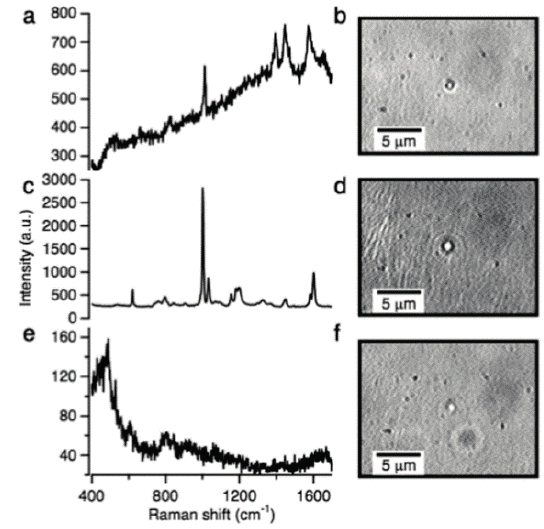
Figure 14. Raman spectra and microscope images of trapped particles of either ( a , b ) Bacillus cereus spores; ( c , d ) polystyrene microspheres; ( e , f ) glass